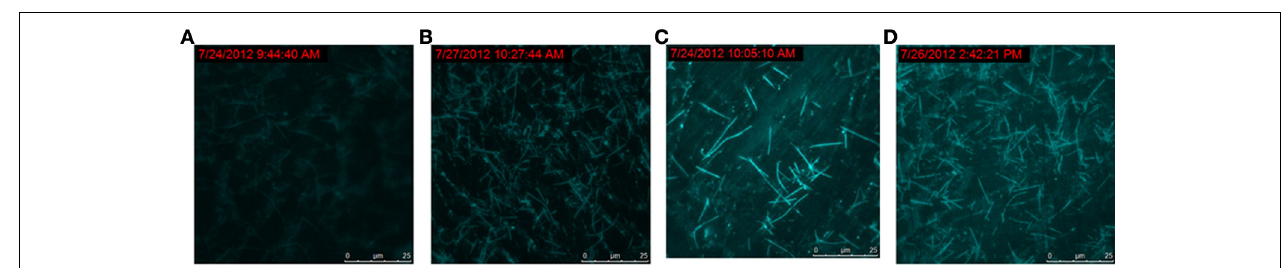
Figure 3A | Products of the molecular machine when different reaction time. (A) 0.5h, (B) 1.0h, (C) 2.0h, (D)